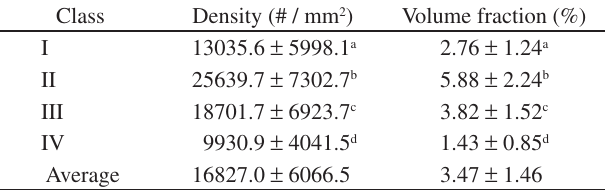
Table 3. Average value and standard deviation of the field parameters grouped per dentin class. The superscript letters have the same definition as in Table